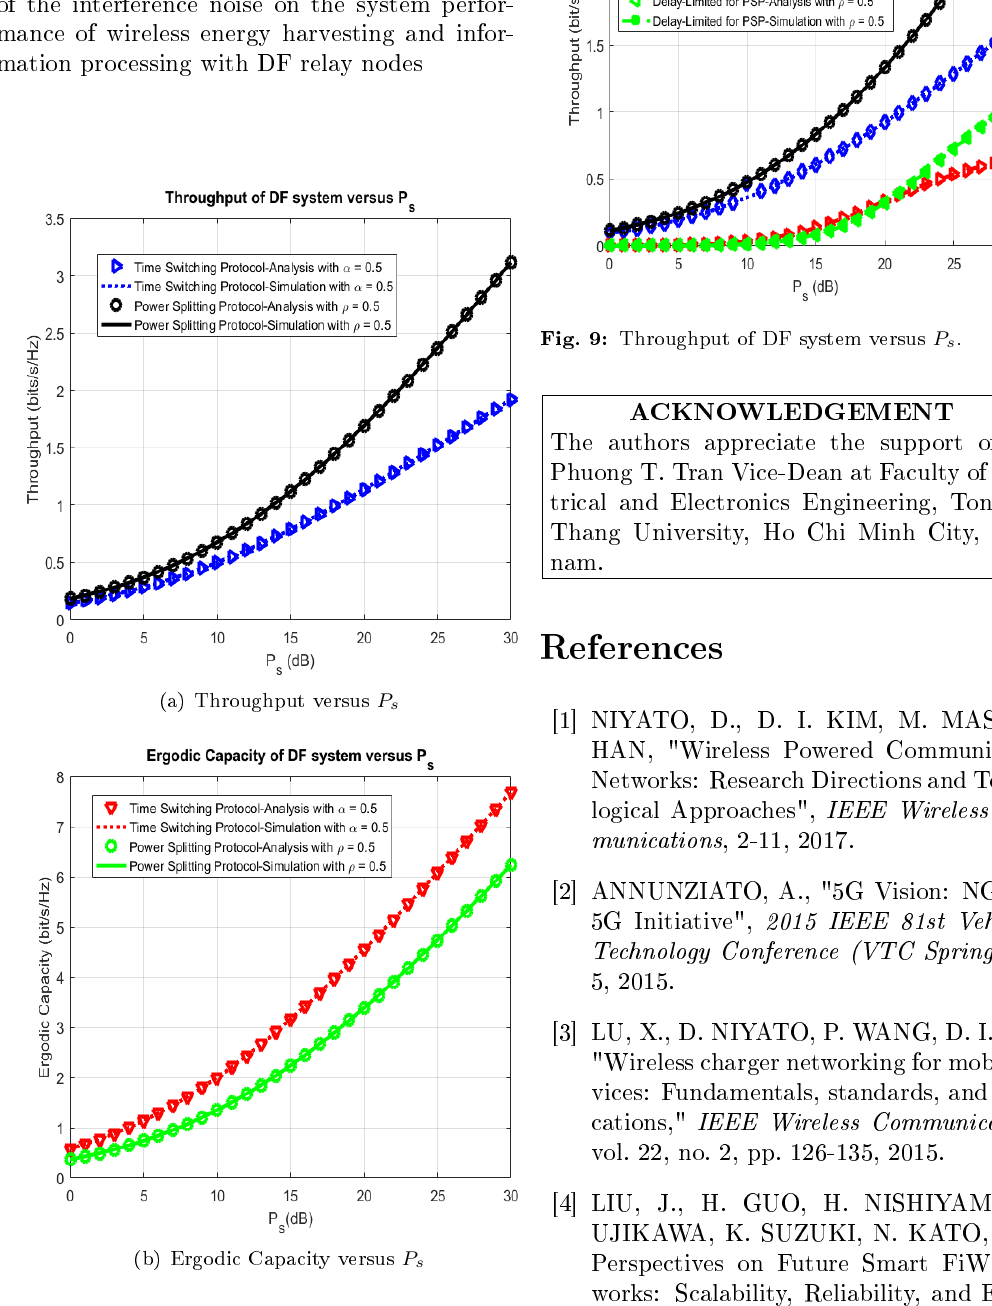
Fig. 8: Delay-Tolerant transmission.